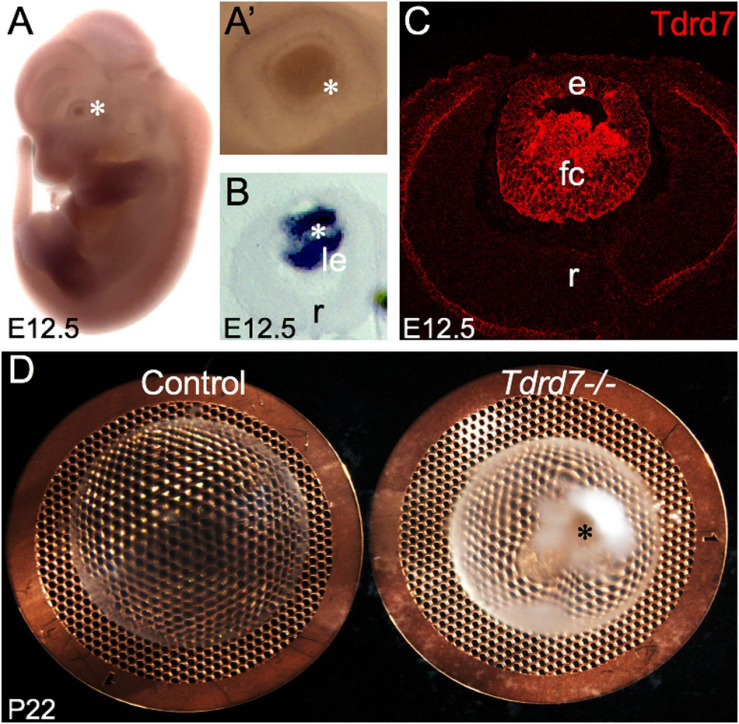
Tdrd7 is expressed in mouse embryonic lens development and its deficiency results in early onset cataract. (A)
In situ hybridization of mouse embryonic day stage E12.5 with Tdrd7-specific probe shows Tdrd7 transcript signal in the eye lens (asterisk), (A’) also clearly observed at high-magnification (asterisk). (B) Section in situ hybridization confirms Tdrd7 transcripts to be expressed in the mouse E12.5 lens (le) and demonstrates it to be primarily localized to fiber cells. (C) Immunofluorescence staining using antibody against Tdrd7 demonstrates its protein abundance (red) in the cytoplasm of lens fiber cells at E12.5. (D)
Tdrd7-/- germline targeted knockout mouse lens show severe cataract (asterisk) compared to normal control at P22 stage. le, lens; r, retina; e, lens epithelium; fc, lens fiber cells.